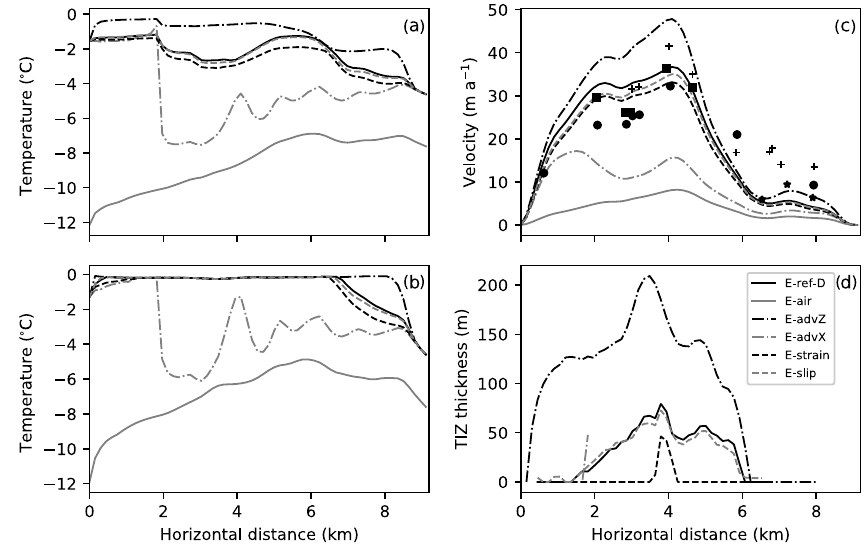
Figure 8. Modelled ice temperatures, velocities, and TIZ thicknesses along the CL for diagnostic experiments E-ref-D (black solid line), E-air (gray solid line), E-advZ (black dash-dotted line), E-advX (gray dash-dotted line), E-strain (black dashed line), and E-slip (gray dashed line). (a) Modelled column mean ice temperatures. (b) Modelled basal ice temperatures. (c) Modelled surface horizontal velocities. (d) Modelled TIZ